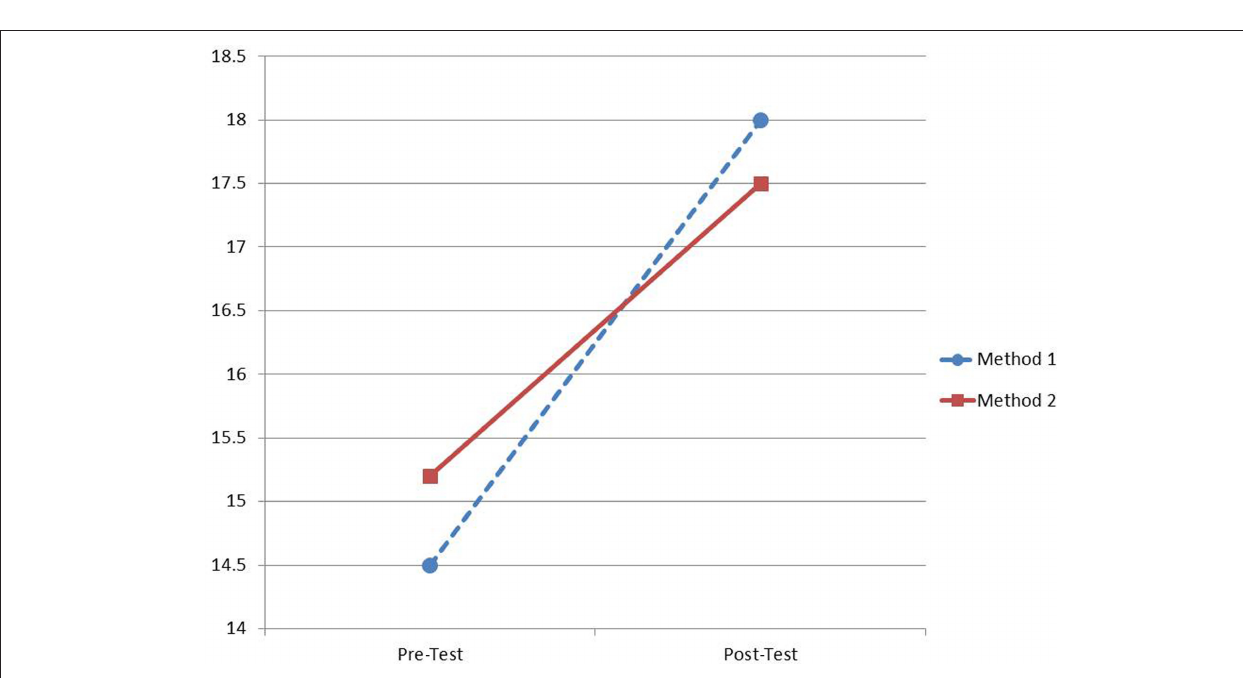
FIgure 2 | Differences in test score growth as a function of instructional method once random responders were removed from the